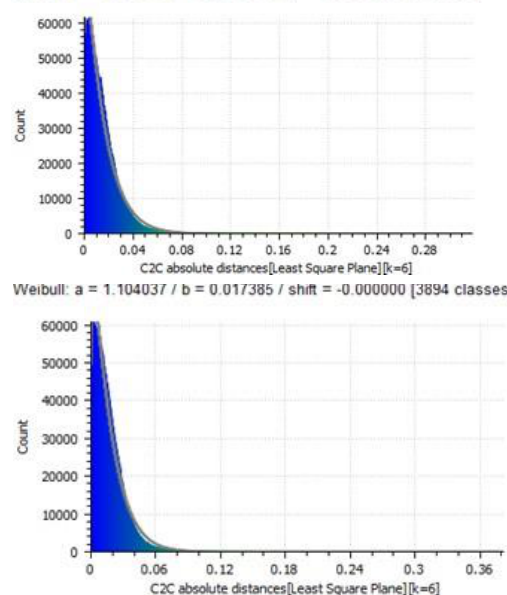
Figure 10: Distribution of the cloud-to-cloud distances between the LiDAR and AT dataset (top) and the LiDAR and DG dataset (bottom) plotted against the Weibull